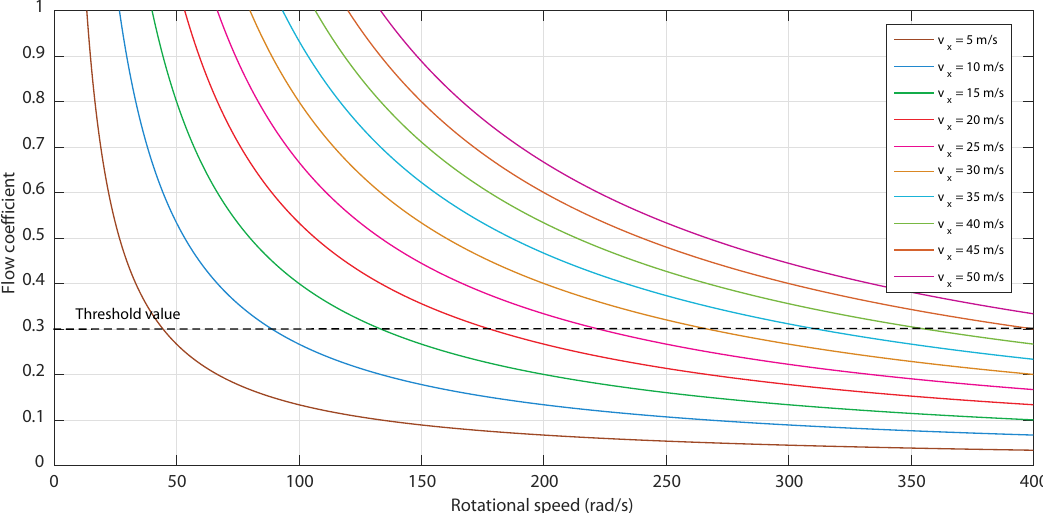
Figure 14. Flow coefficient vs rotor rotational speed for different incoming airflow speed. For the same incoming airflow speed from the same wave amplitudes and periods the torque obtained against the rotational speed is presented in Figure 15.